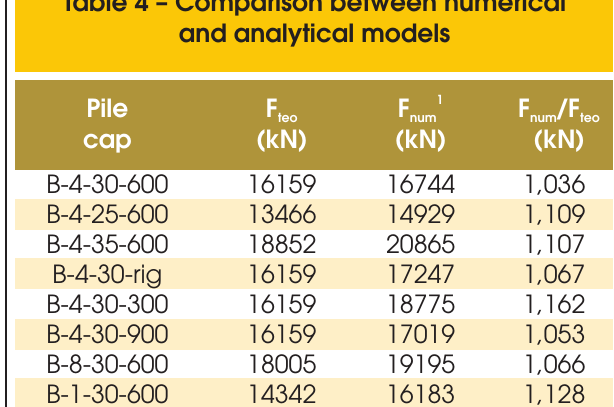
Table 4 – Comparison between